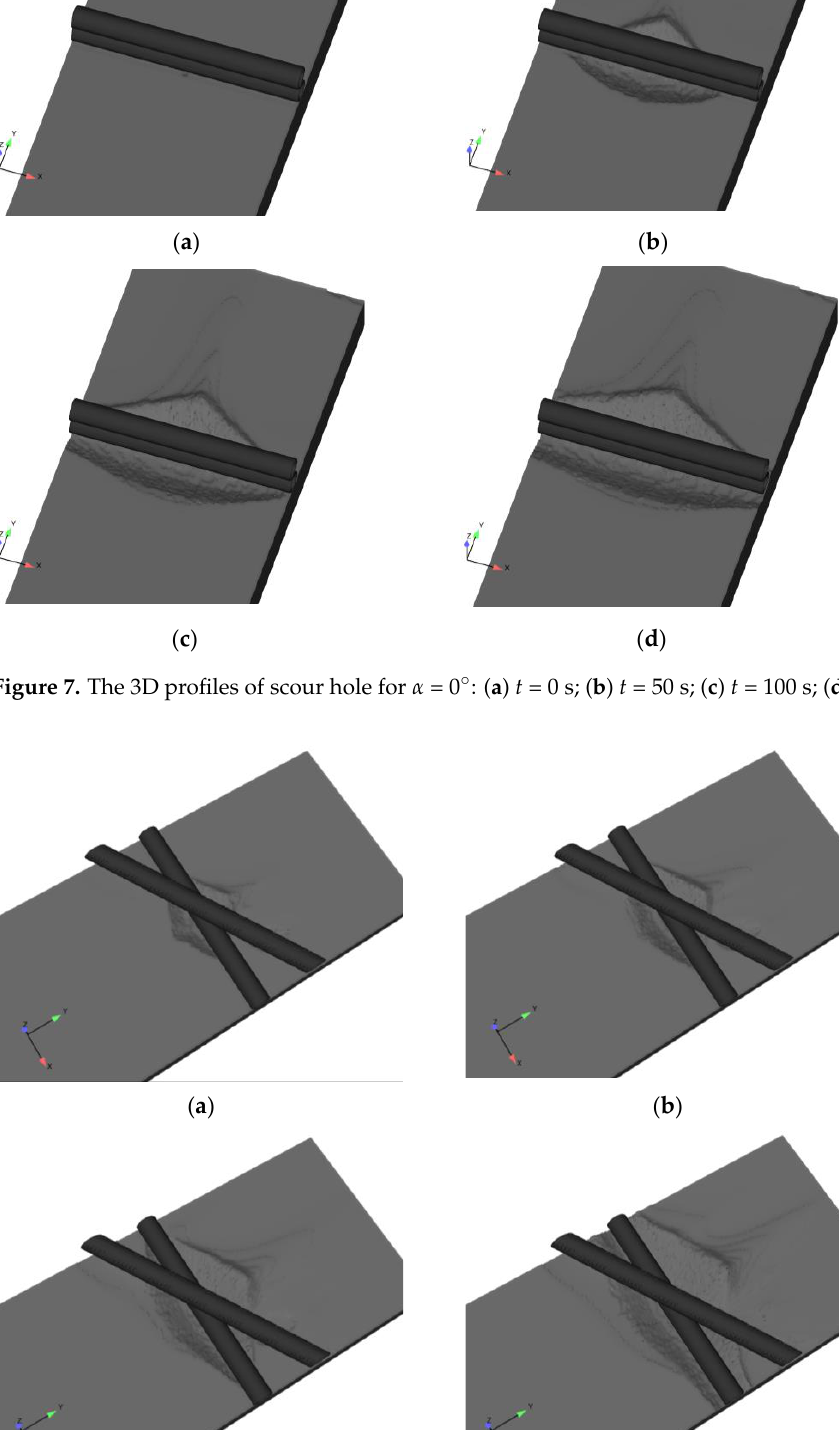
( d ) Figure 7. The 3D profiles of scour hole for α = 30°: ( a ) t = 0 s; ( b ) t = 100 s; ( c ) t = 200 s; ( d ) t = 350 s.